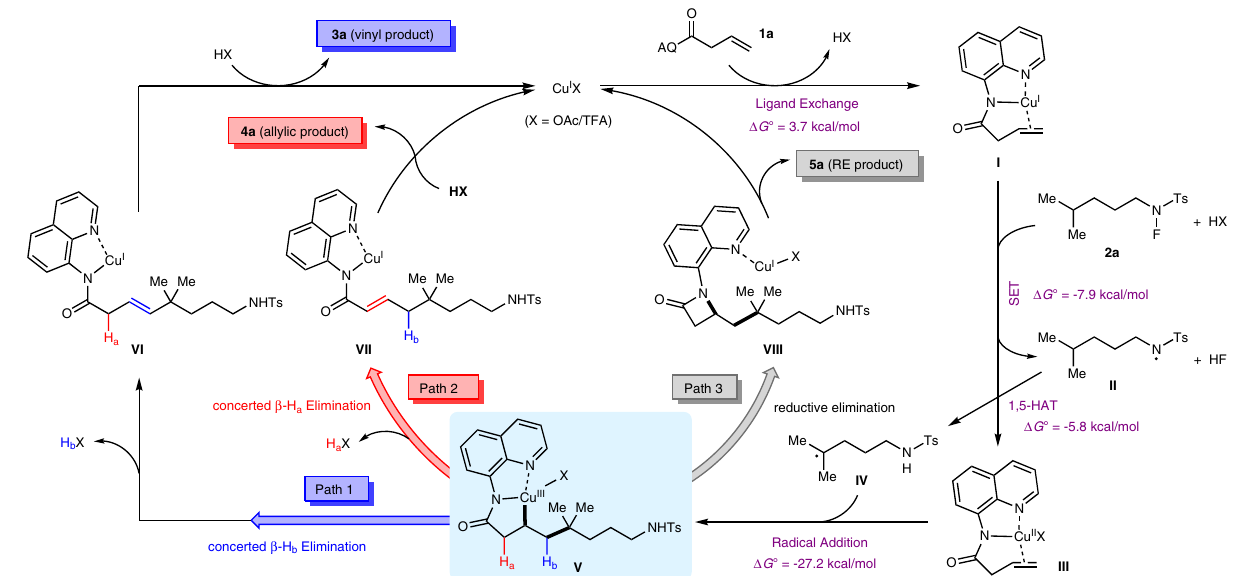
Fig. 8 | The proposed mechanism. Three plausible different reaction pathways for the intermolecular Heck-type reaction of unactivated alkenes and N - fl uoro-